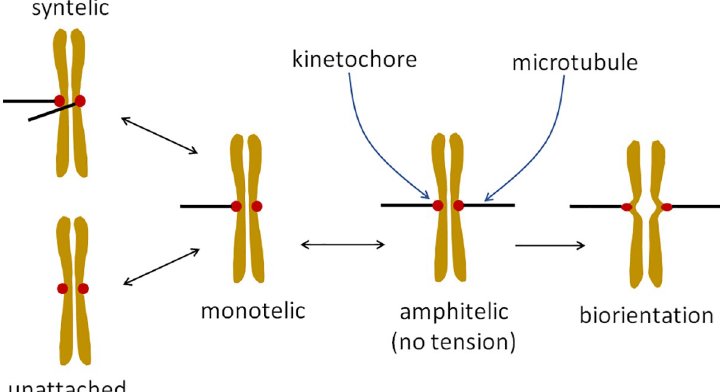
Fig 1. Model for transitions of sister chromatids between different KT-MT attachment states. Double-headed arrows denote reversible transitions, whereas the single-headed arrow denotes an irreversible transition from the amphitelic state (centromere not under tension) to the biorientation state (centromere under tension).